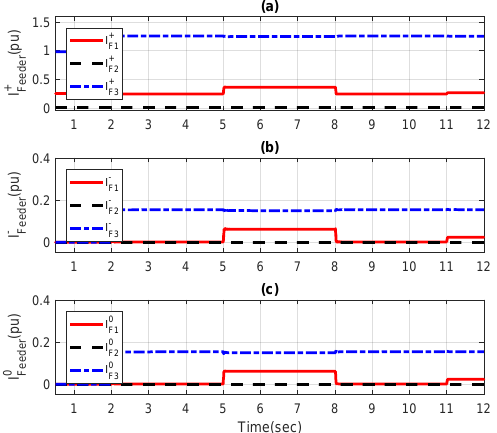
Figure 16. ( a ) positive and ( b ) negative, and ( c ) zero-sequence currents of the